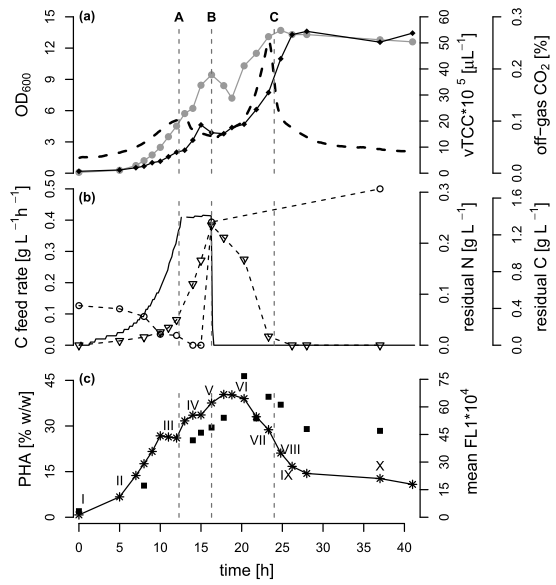
Figure 1. Bioprocess data of the fed-batch fermentation. A fed-batch cultivation of Pseudomonas putida KT2440 was carried out with an exponential feed of octanoic acid (C8), followed by a poly(hydroxyalkanoate) (PHA) depolymerization phase under carbon limitation. The dashed lines indicate A: the time point 12.3 h when the feed changed from exponential to linear mode, B: the time point 16.3 h when the carbon feeding was stopped and an ammonium pulse was added, and C: the time point 24 h when the carbon source was depleted. ( a ) Optical density (•, OD 600 ), volumetric total cell count ( ♦ vTCC), CO 2 content in the off-gas (--); ( b ) Carbon (C) feed rate (-), carbon and nitrogen content in the culture supernatant ( ∇ residual C, ◦ residual N); ( c ) PHA quantity as determined by gas chromatography (GC) analysis ( ∎ ) and by measuring the mean green fluorescence ( mean FL1) of BODIPY 493/503 stained cells with flow cytometry (FCM). The Roman numbers (I–X) in proximity of the mean FL1 values mark the FCM samples depicted in Figure 3 in Section 3.3.